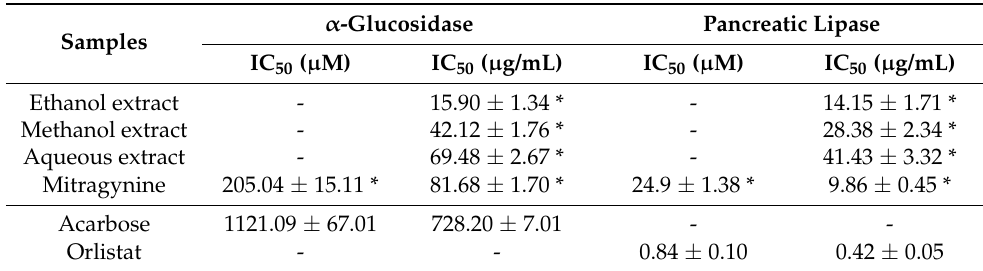
Table 4. The IC 50 values of kratom extracts and mitragynine for α -glucosidase and pancreatic lipase inhibitory activities.